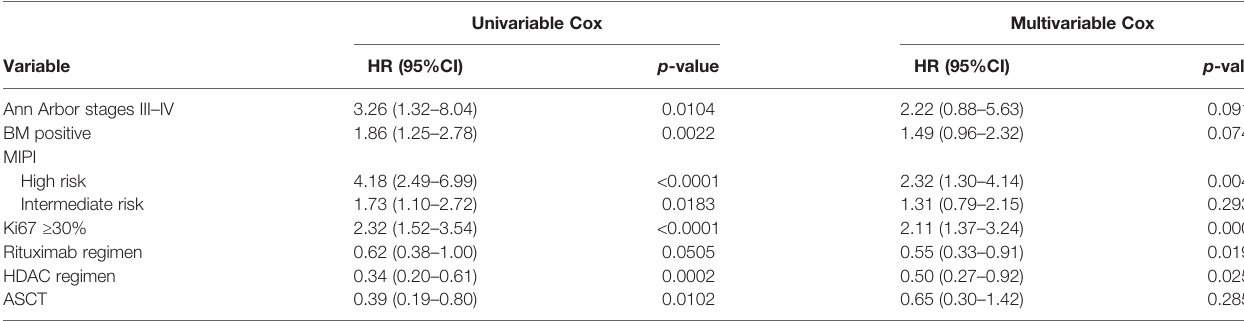
TABLE 4 | Univariate and multivariate predictor